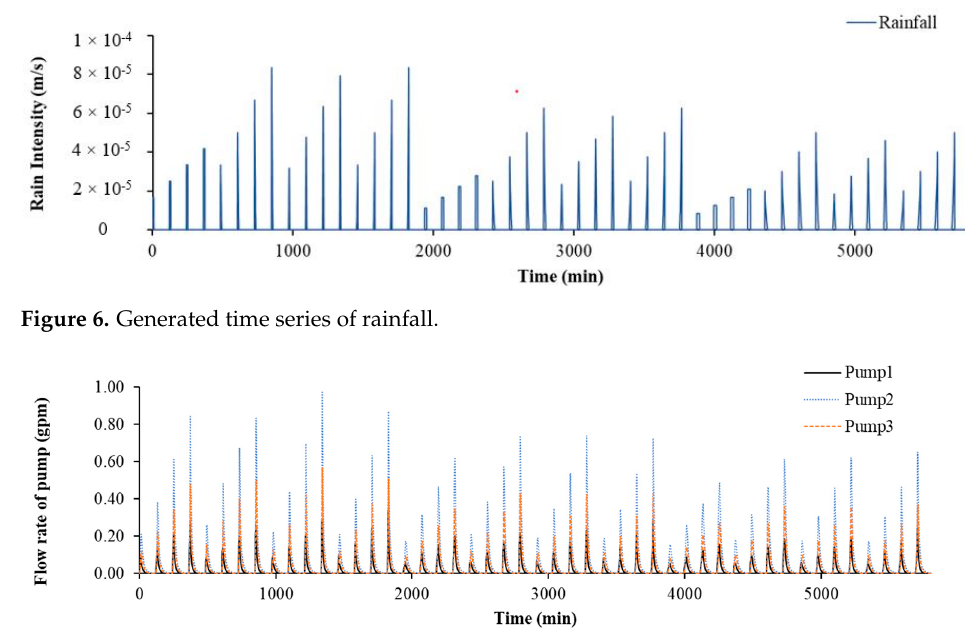
Figure 7. Time series of flow rates for pumps 1, 2, and 3 corresponding to the generated rainfall data.